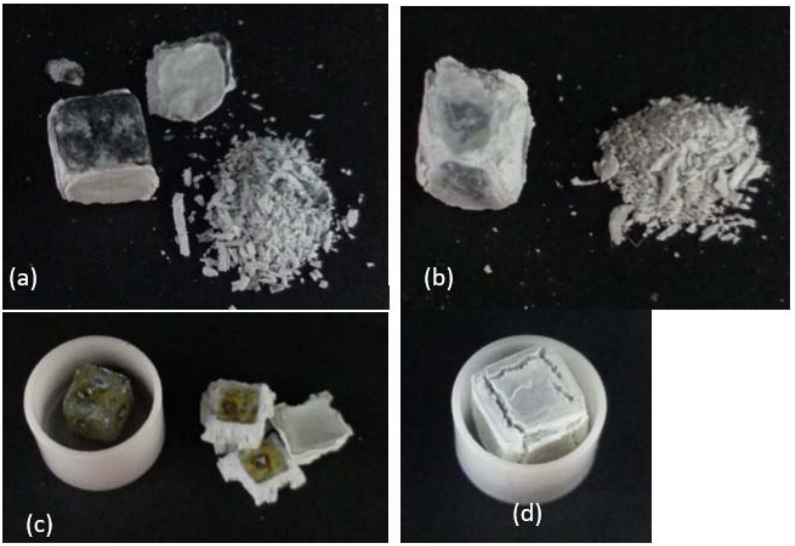
Figure 7. The specimens of the alloys JZ1 ( a , c ) and JZ2 ( b ,d) after oxidation at 800 °C ( a , b ) and 1200 °C ( c ),( d ). The size of each oxidation specimen was 3 × 3 × 3 mm 3 .